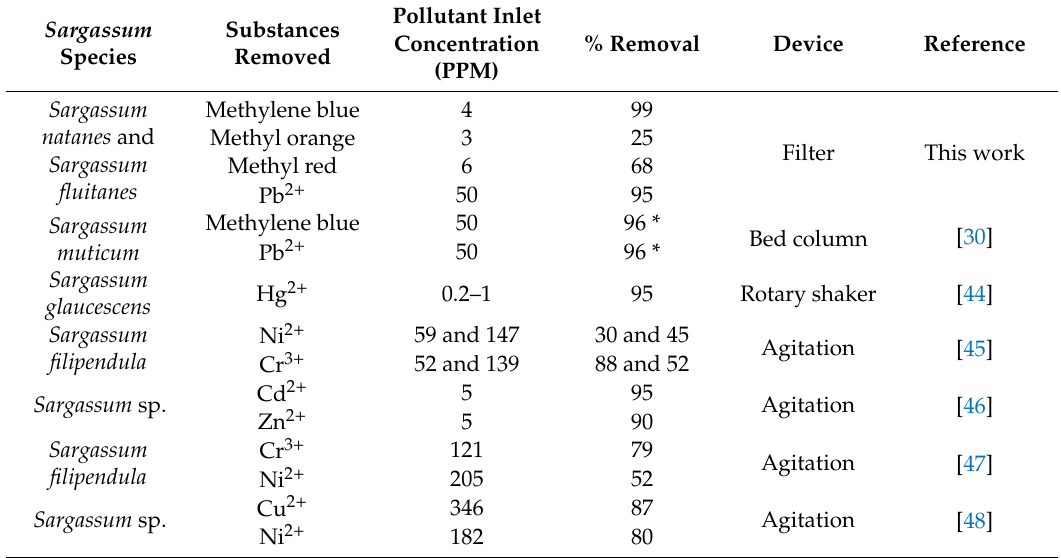
Table 2. Comparison of results reported which used Sargassum species for substance